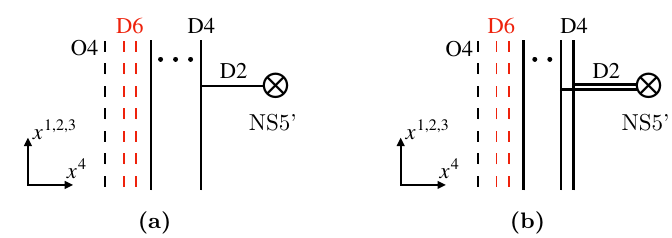
Figure 4. (a): a realization of the minimal ’t Hooft operator corresponding to V and B = e n . (b): a realization of the ’t Hooft operator corresponding to ∧ 2 V and B = e n − 1 + e n .